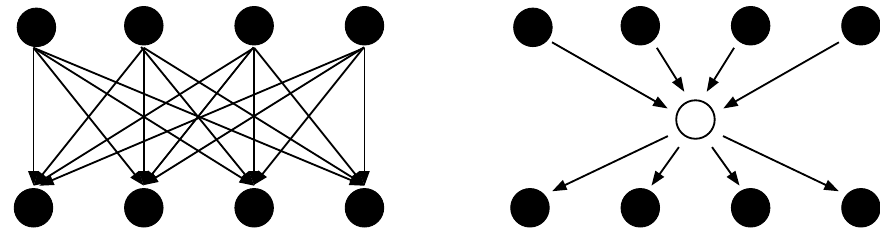
Figure 2. The method by Buehrer and Chellapilla [7] compresses a complete bipartite graph (left) by introducing a virtual node